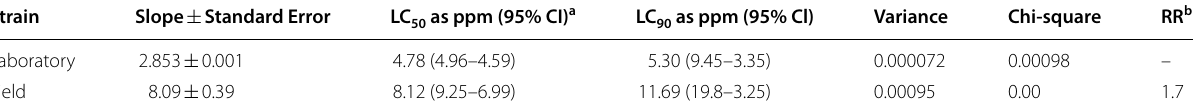
a Confidence interval at 95% probability level; b: Resistance Ratio